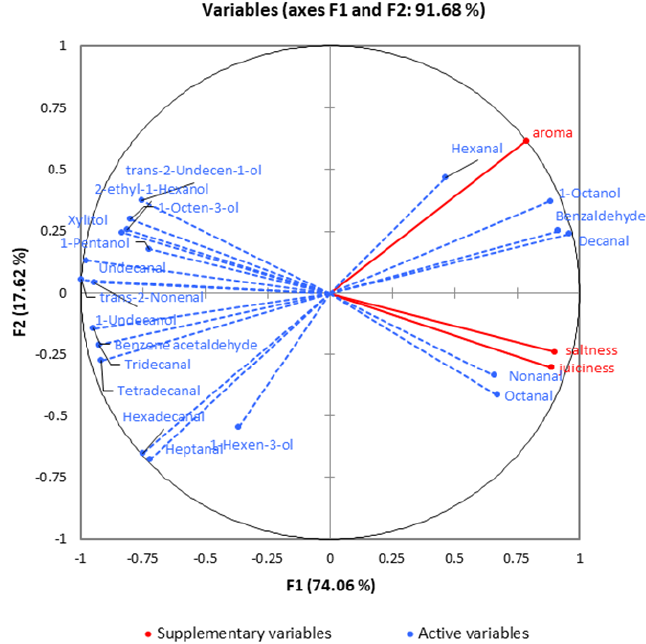
Figure 5. PCA results of the main volatile compounds and sensory attributes. Red solid lines represent sensory attributes, blue dashed lines represent volatile compounds.